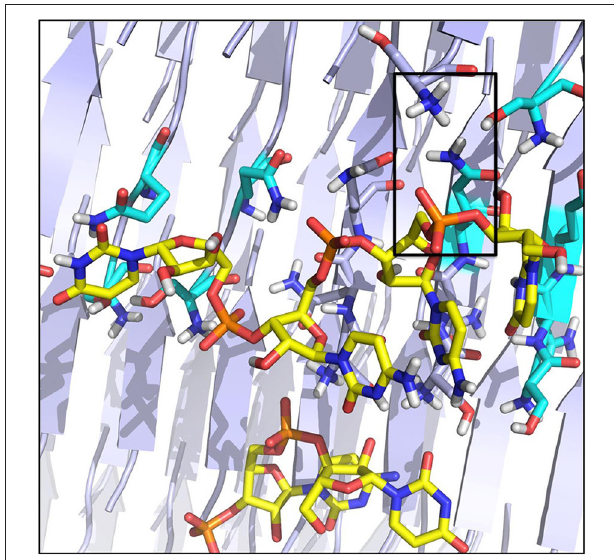
FIGURE 5 | Organization of the RNA tetramer on the surface of the SNQNNF aggregate. Detail of the different h-bonds and electrostatic interactions on the surface. Electrostatic interactions are highlighted with a black box.